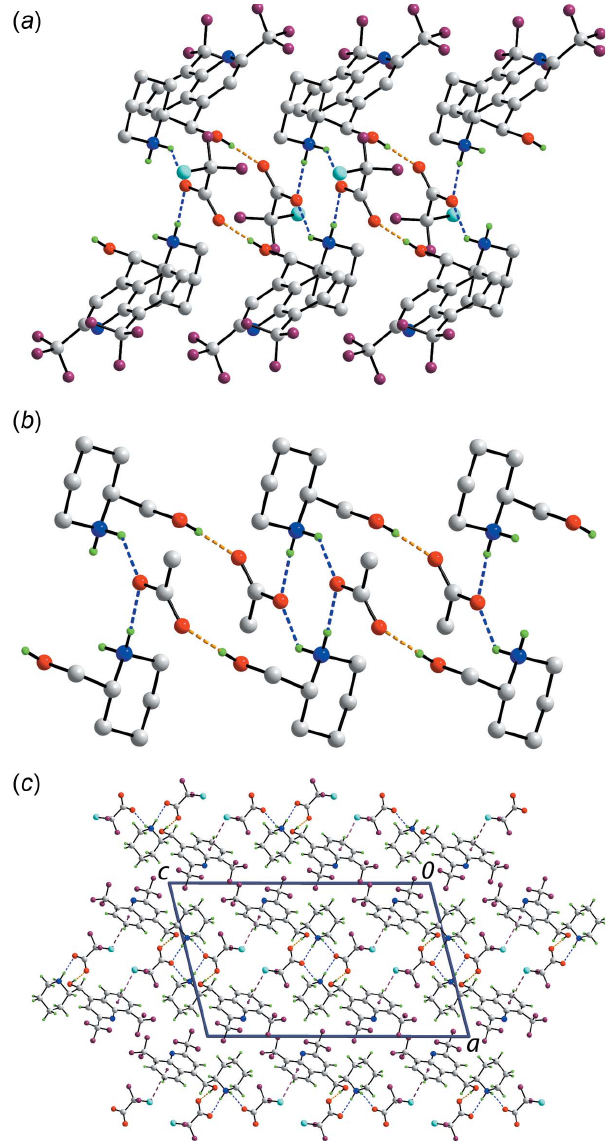
Figure 2 Molecular packing in (I): ( a ) The supramolecular chain along the b -axis direction, being sustained by O—H (cid:2)(cid:2)(cid:2) O and N—H (cid:2)(cid:2)(cid:2) O hydrogen bonding with non-participating H atoms omitted, ( b ) a simplified view of the chain highlighting the formation of the eight- and 18-membered supramolecular synthons and ( c ) a view of the unit-cell contents shown in projection down the b -axis direction. The O—H (cid:2)(cid:2)(cid:2) O, N—H (cid:2)(cid:2)(cid:2) O and Cl (cid:2)(cid:2)(cid:2) (cid:2) interactions are shown as orange, blue and purple dashed lines, respectively.